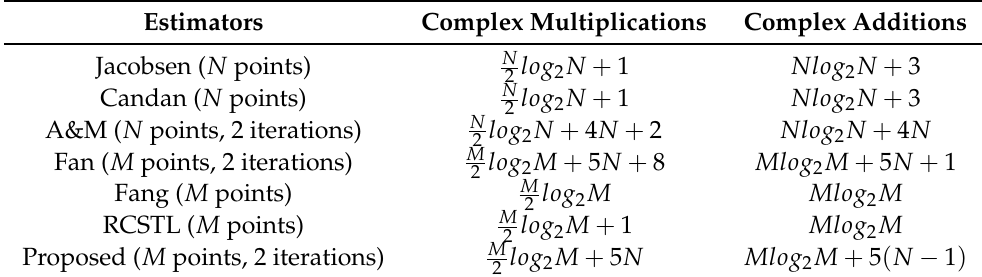
Table 2. Computational complexities of the estimators used in the